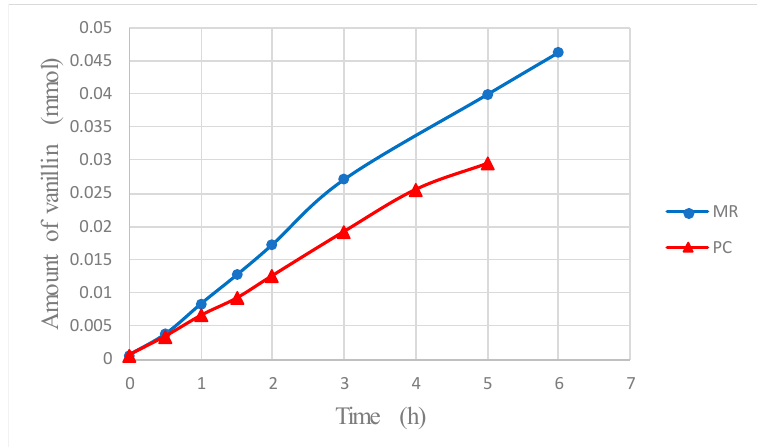
Figure 11. Total amount of vanillin in the experimental set-ups (i.e., for the MR, the sum of the amount of vanillin in the reacting solution plus the one in the permeate) vs. time. The operating conditions are the same as those in Figure 8.